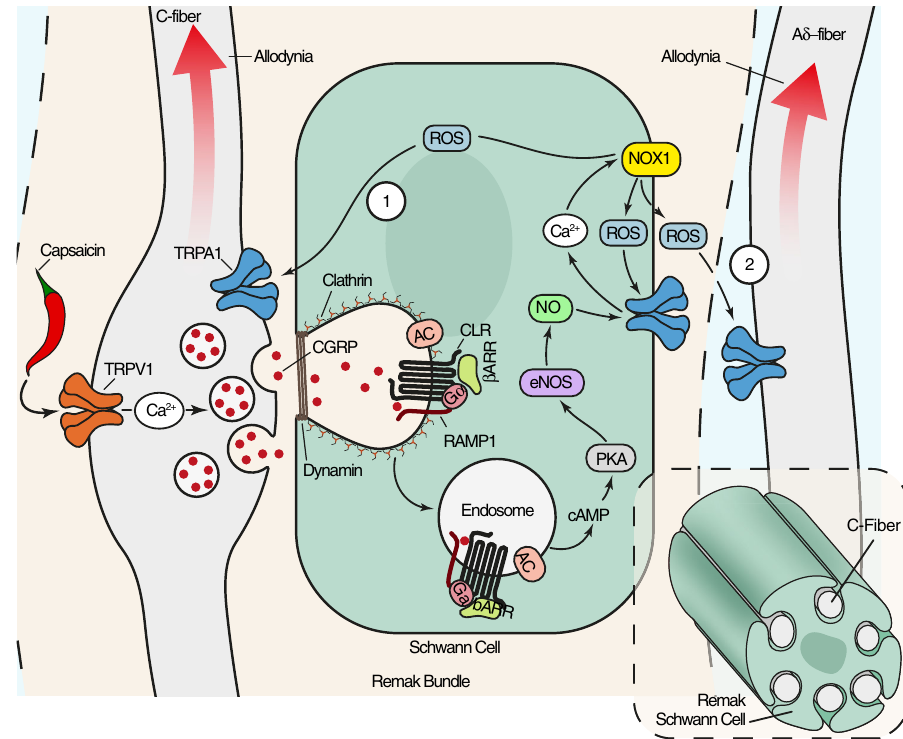
Fig. 9 Schematic representation of the pathway that signal prolonged cutaneous allodynia elicited by CGRP released and associated with neurogenic in fl ammation. The pro-migraine neuropeptide, CGRP, released from trigeminal cutaneous afferents, activates CLR/RAMP1 on Schwann cells. CLR/RAMP1 traf fi cs to endosomes, where sustained G protein signaling increases cAMP and stimulates PKA that results in nitric oxide synthase activation. The ensuing release of nitric oxide targets the oxidant-sensitive channel, TRPA1, in Schwann cells, which elicits persistent ROS generation. ROS triggers TRPA1 on adjacent C- (1) or A δ - fi ber (2) afferents resulting in periorbital allodynia, a hallmark of migraine pain. The inset shows several unmyelinated axons invaginated into a Schwann cell forming a Remak